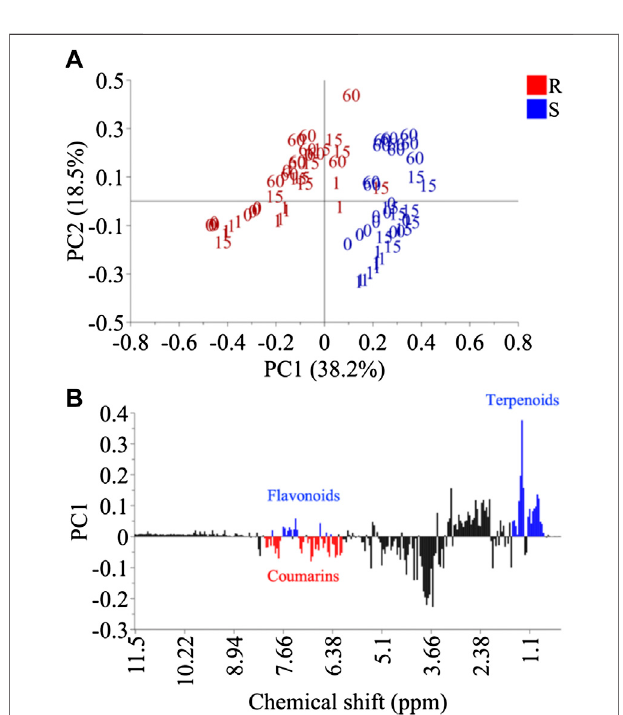
FIGURE 3 | Principal component analysis of Citrus limon (S) and Citrus latifolia (R). Score plot using PC1 and PC2 (A) and loading plot of PC1 (B) .